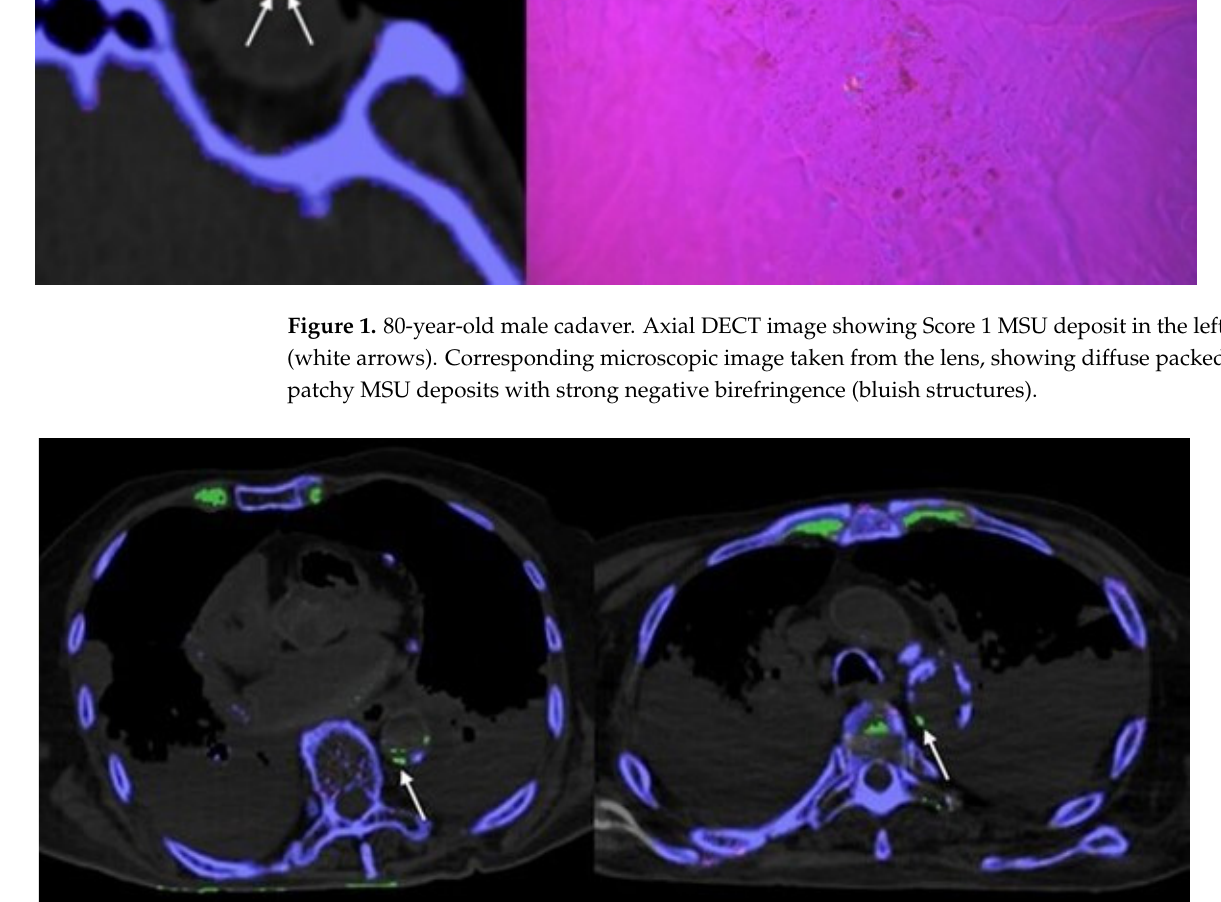
Figure 2. Axial DECT images showing histologically verified Score 1 MSU deposits in thoracic aorta (white arrows). Note: MSU deposits in anterior costochondral cartilage and intervertebral disc.